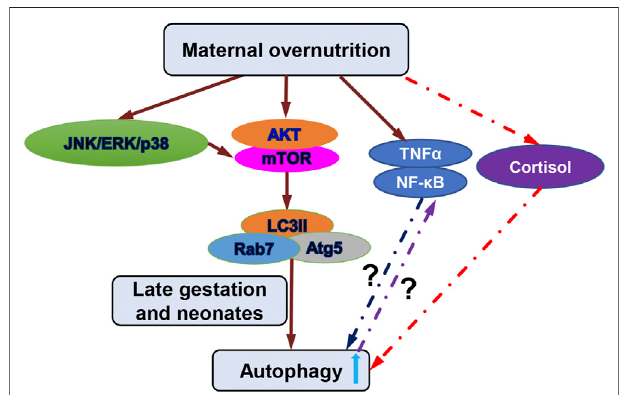
FIGURE 6 | Schematic diagram of autophagy associated signaling pathways and potential mechanisms regulated by maternal overnutrition. Important hallmark proteins in the PI3K/Akt/mTOR and the MAPK/ERK signaling are indicated which were examined in this study. Alternation of these hallmark proteins in later gestation and early postnatal life increased autophagy. Cortisol level did not change in heart tissues and was not the cause for the increased autophagy in later gestation and early postnatal life indicatedbyreddash line.In fl ammatoryfactors TNF α and NF- κ Bwerealtered by maternal overnutrition in early gestation but not late gestation or early postnatal life in which the possible mechanisms could be that increased in fl ammatory factors in early gestation inhibits autophagy (blue dash line and question mark) and unchanged in fl ammatory factors at late gestation and early postnatal life could be suppressed by increased autophagy (purple dash line and question